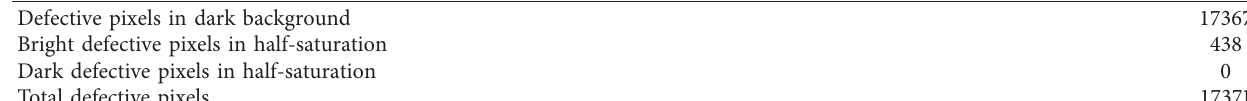
Table 2: Defective pixels test results.